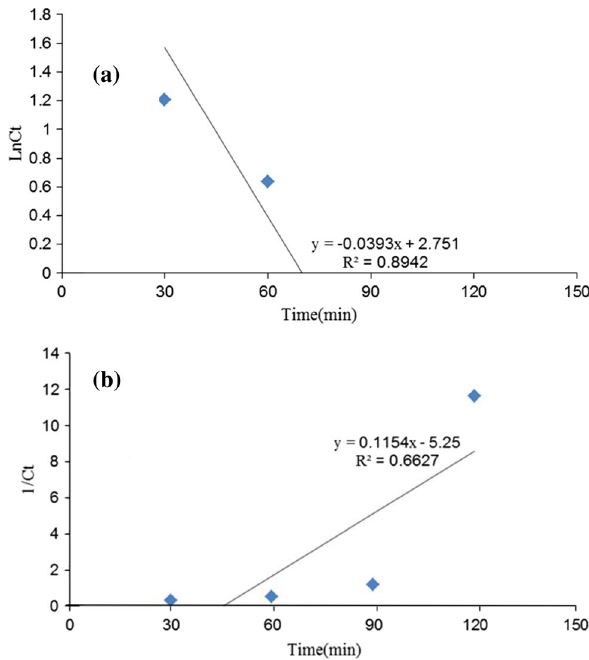
Fig. 13 Comparison of the first-order kinetic ( a ) and second-order kinetic ( b ) model for the photocatalytic degradation of amoxicillin at C